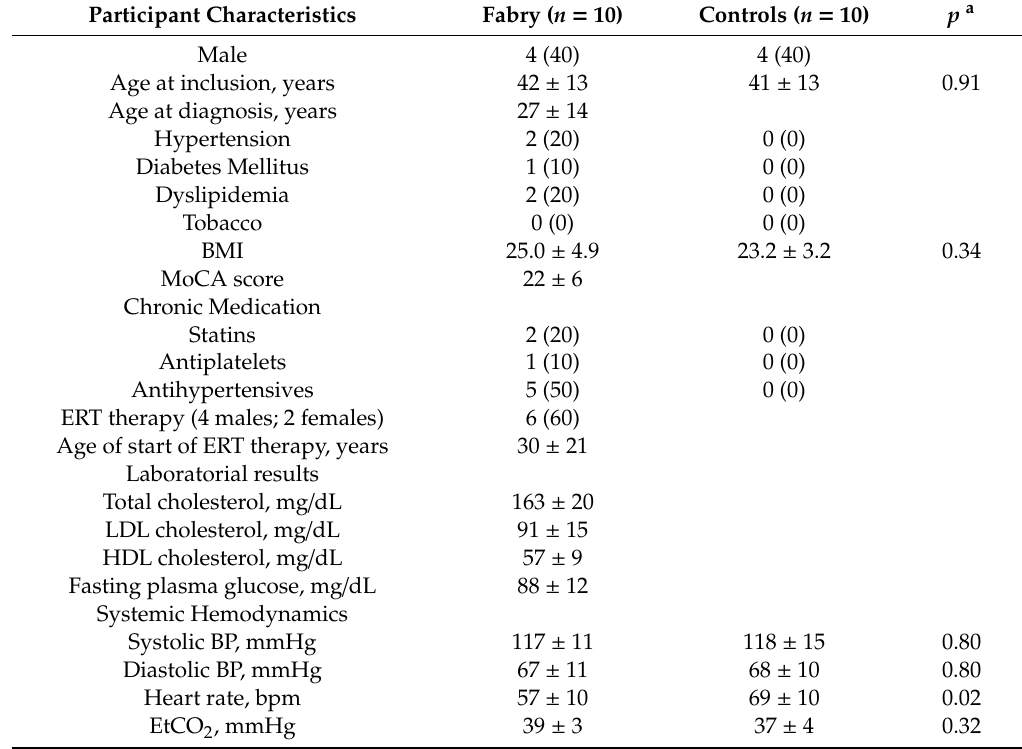
Table 1. Baseline characteristics of Fabry disease patients and